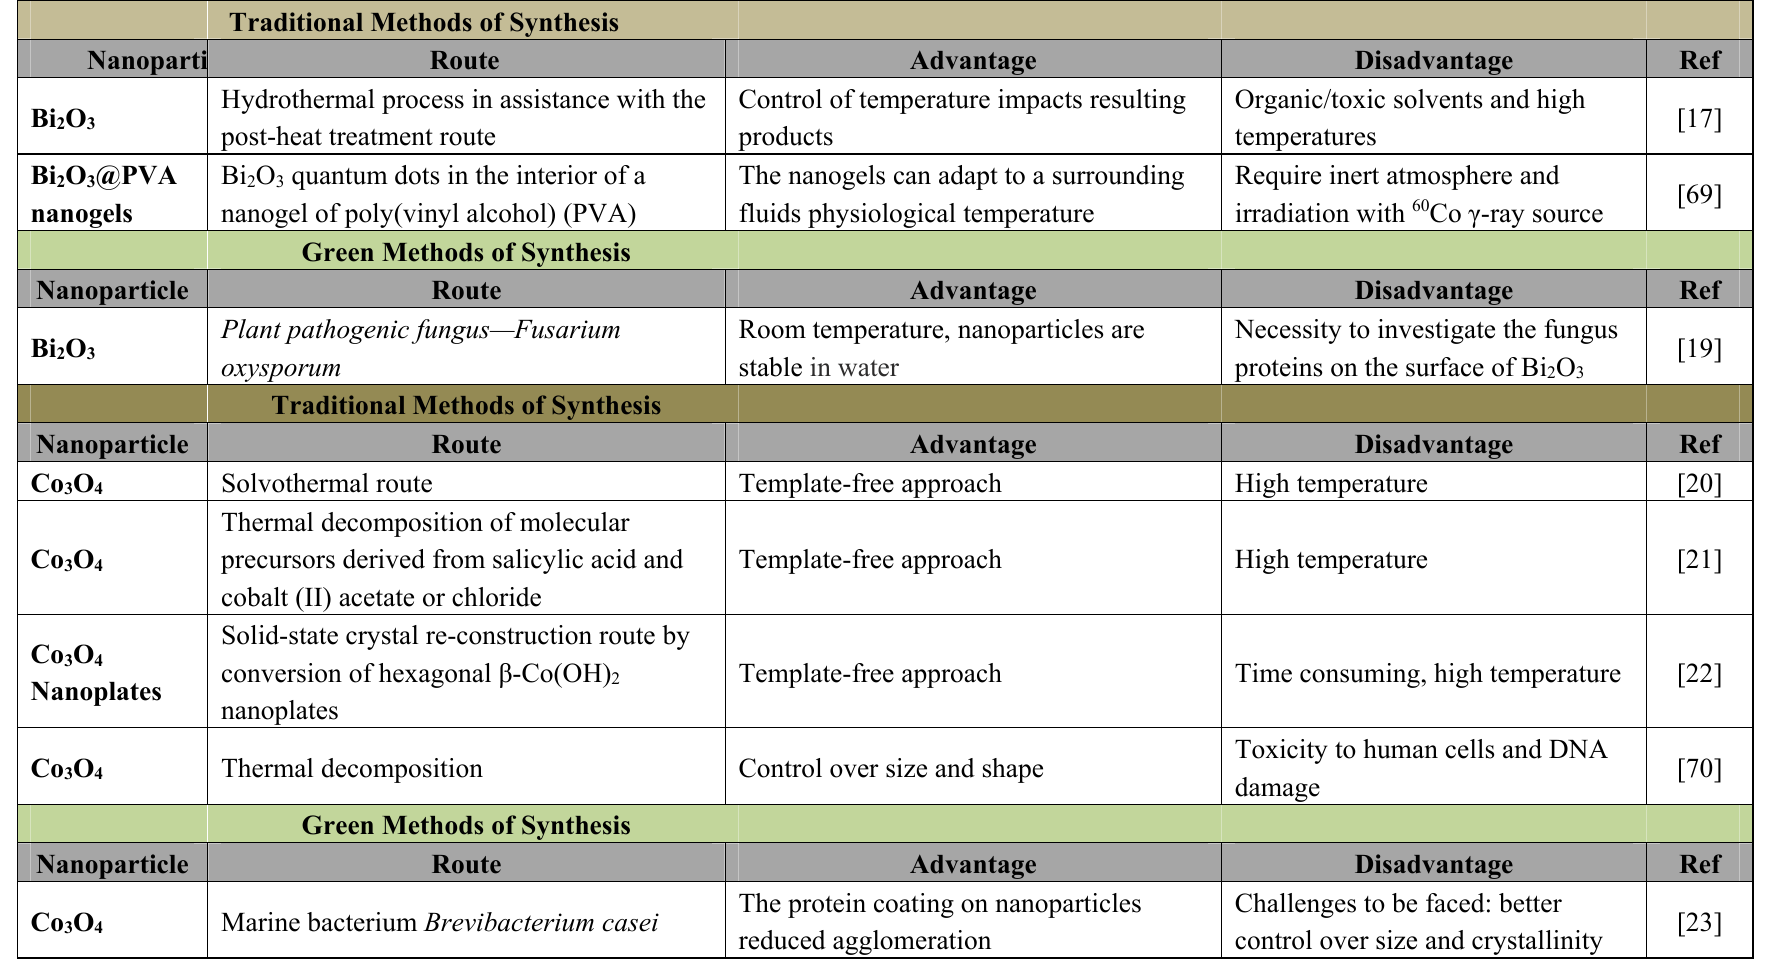
Table 1. Comparison among main traditional versus green methods to synthesize metal oxide